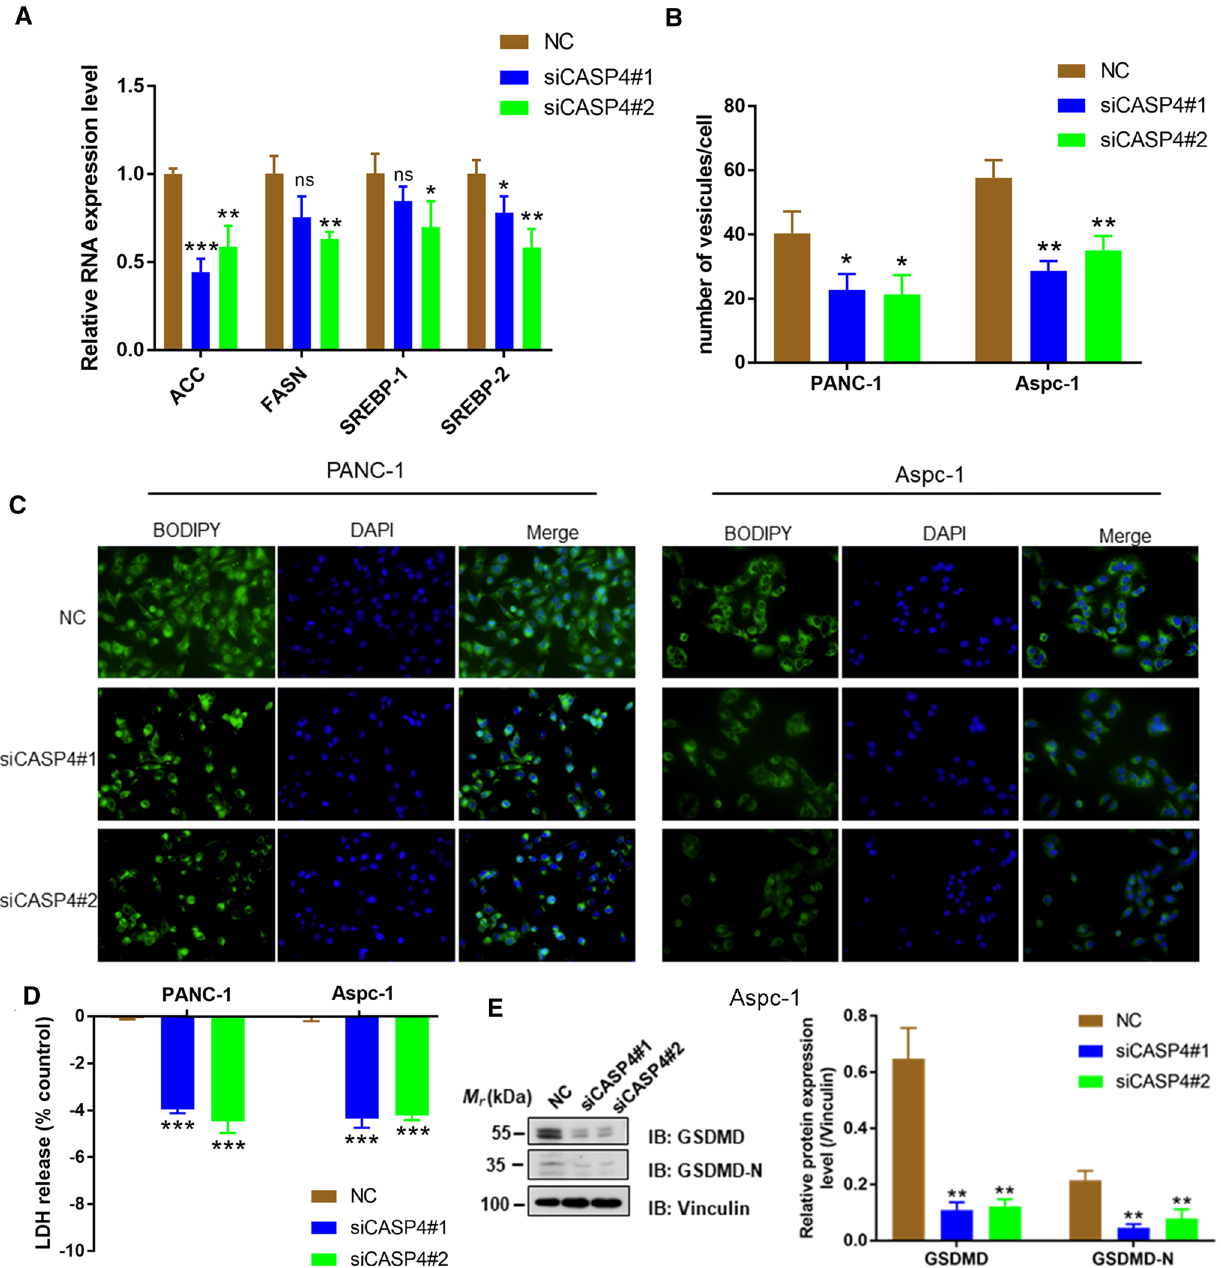
Fig. 8 CASP4 promoted tumor progression by regulating accumulation of lipid droplets. A RNA expression level of key enzyme molecules in fatty acid synthesis after transfecting shCASP4 in PANC-1 and Aspc-1 cells. B , C The mean number of lipid vesicles per cell. The lipid droplets were counted randomly (≥ 50 cells were counted per condition). D PANC-1 and Aspc-1 cells were tested for LDH release 24 h after siCASP4 transfection. E Cleavage of GSDMD were monitored by immunoblot analysis 48 h after siCASP4 transfection (*P < 0.05, **P < 0.01, ***P <